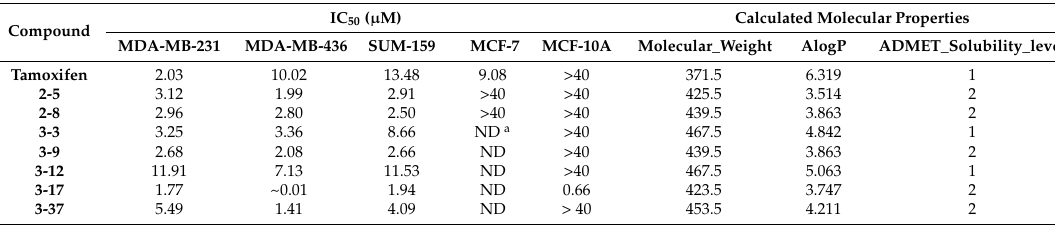
Table 6. IC 50 of compounds measured on different cell lines and calculated molecular properties. Compound